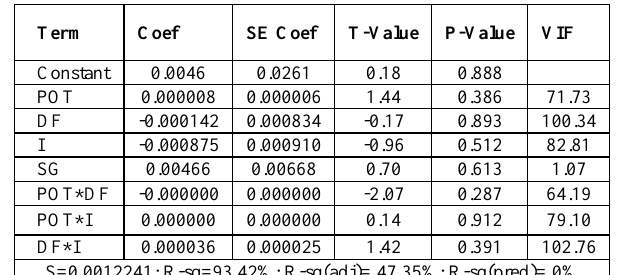
Table 2. Estimated regression coefficient for